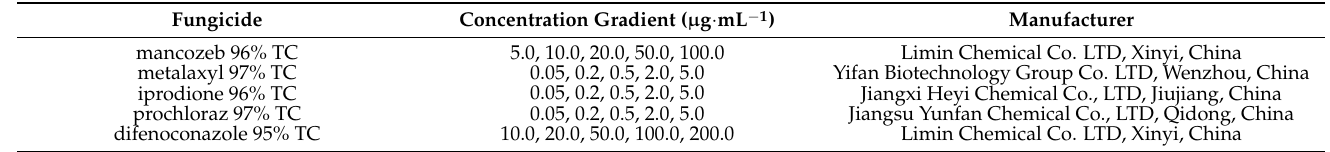
Table 1. Fungicides and their